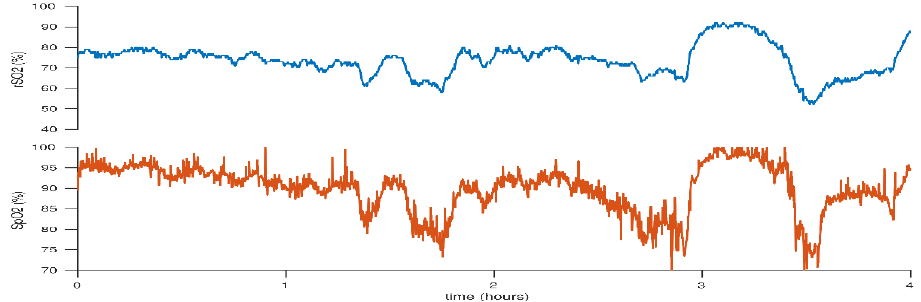
Figure 6. Cerebral hyperoxia following an episode of desaturation treated with increased FiO 2 . This figure reflects the case of a neonate born at 25 + 2 weeks gestation. BW 530 g, DOL 3.